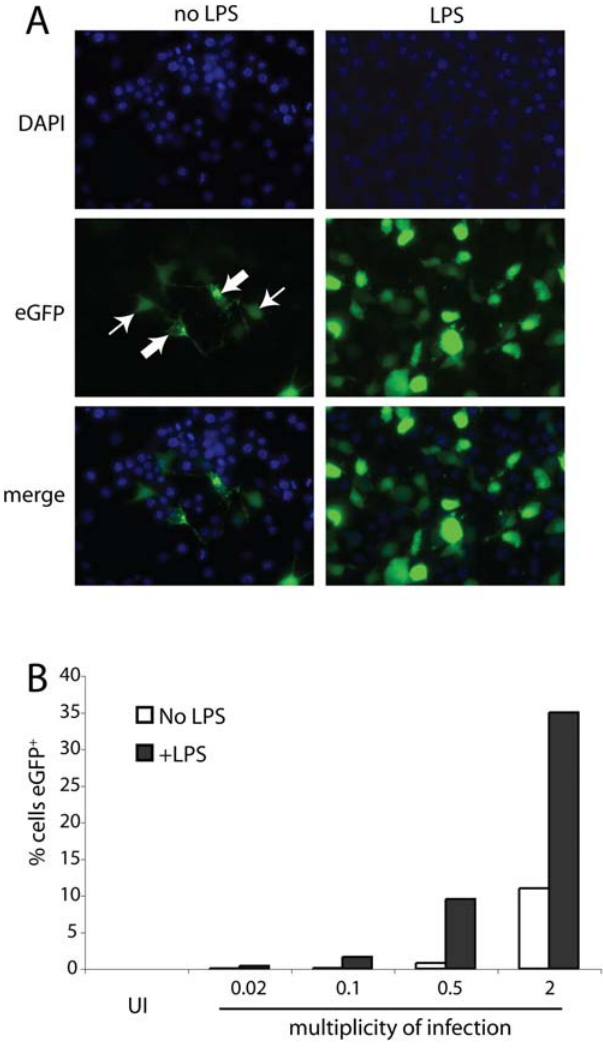
Figure 7. BAC + eGFP and gM-eGFP are differentially affected by LPS. A. RAW264.7 cells were infected with BAC + gM-eGFP + MHV-68 (2PFU/ cell, 18 h), then treated for 4 h with LPS (100 ng/ml). The cells were then fixed and examined for eGFP expression (green). Nuclei were counterstained with DAPI (blue). The thick arrows show gM-eGFP + cells and the thin arrows BAC + eGFP + cells. B. RAW264.7 cells were infected with BAC + gM-eGFP + MHV-68 at different multiplicities. 18 h later the cells were treated for 4 h with LPS (100 ng/ml). Total eGFP expression (BAC + eGFP plus gM-eGFP) was then quantitated by flow cytometry.